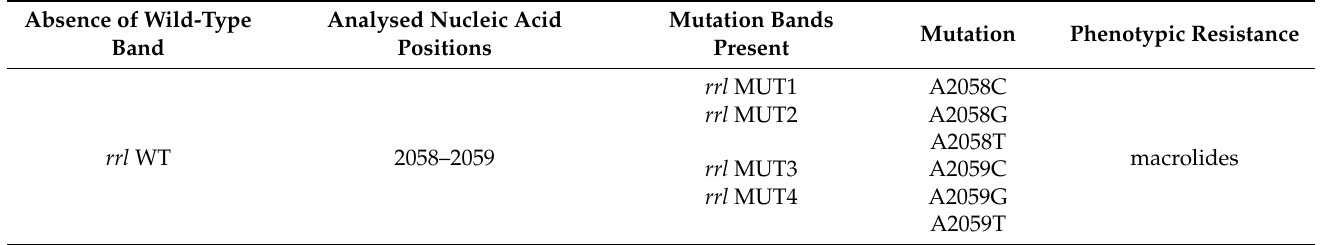
Table 1. Mutations determining resistance to macrolides detected using the GenoType NTM-DR assay within the rrl gene.